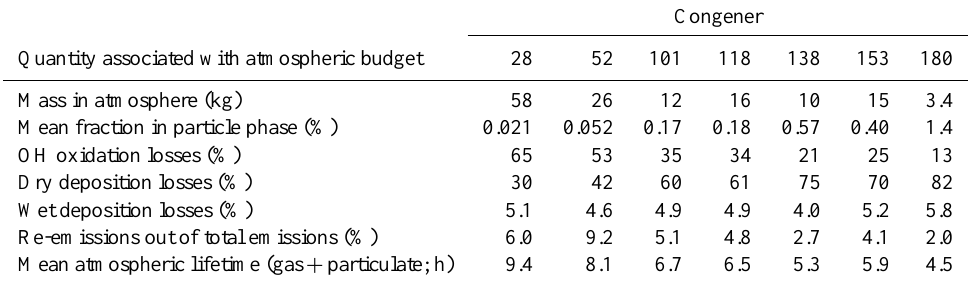
Table 4. Mean 2006–2010 atmospheric budget of PCBs. For all congeners, total wet and dry deposition was dominated by the gas phase ( > 99% attributable to the gas phase).